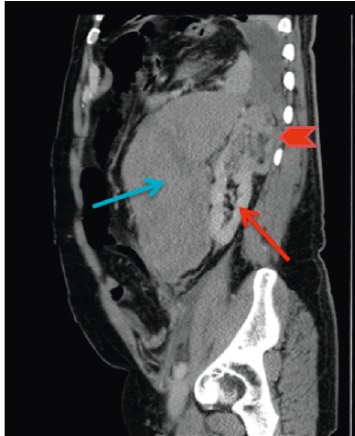
Figure 1: Contrast sagittal section shows a large hematoma at the left retroperitoneal region (blue arrow), the normal-appearing left kidney (thin red arrow), and an exophytic left upper pole renal mass (red arrowhead).